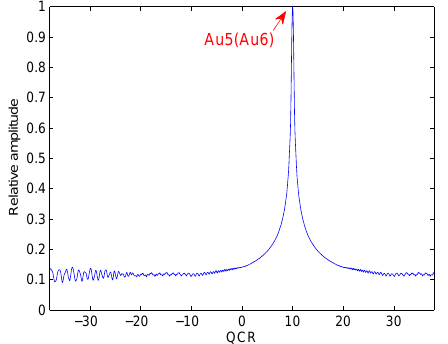
Figure 3. Cross-term suppression of